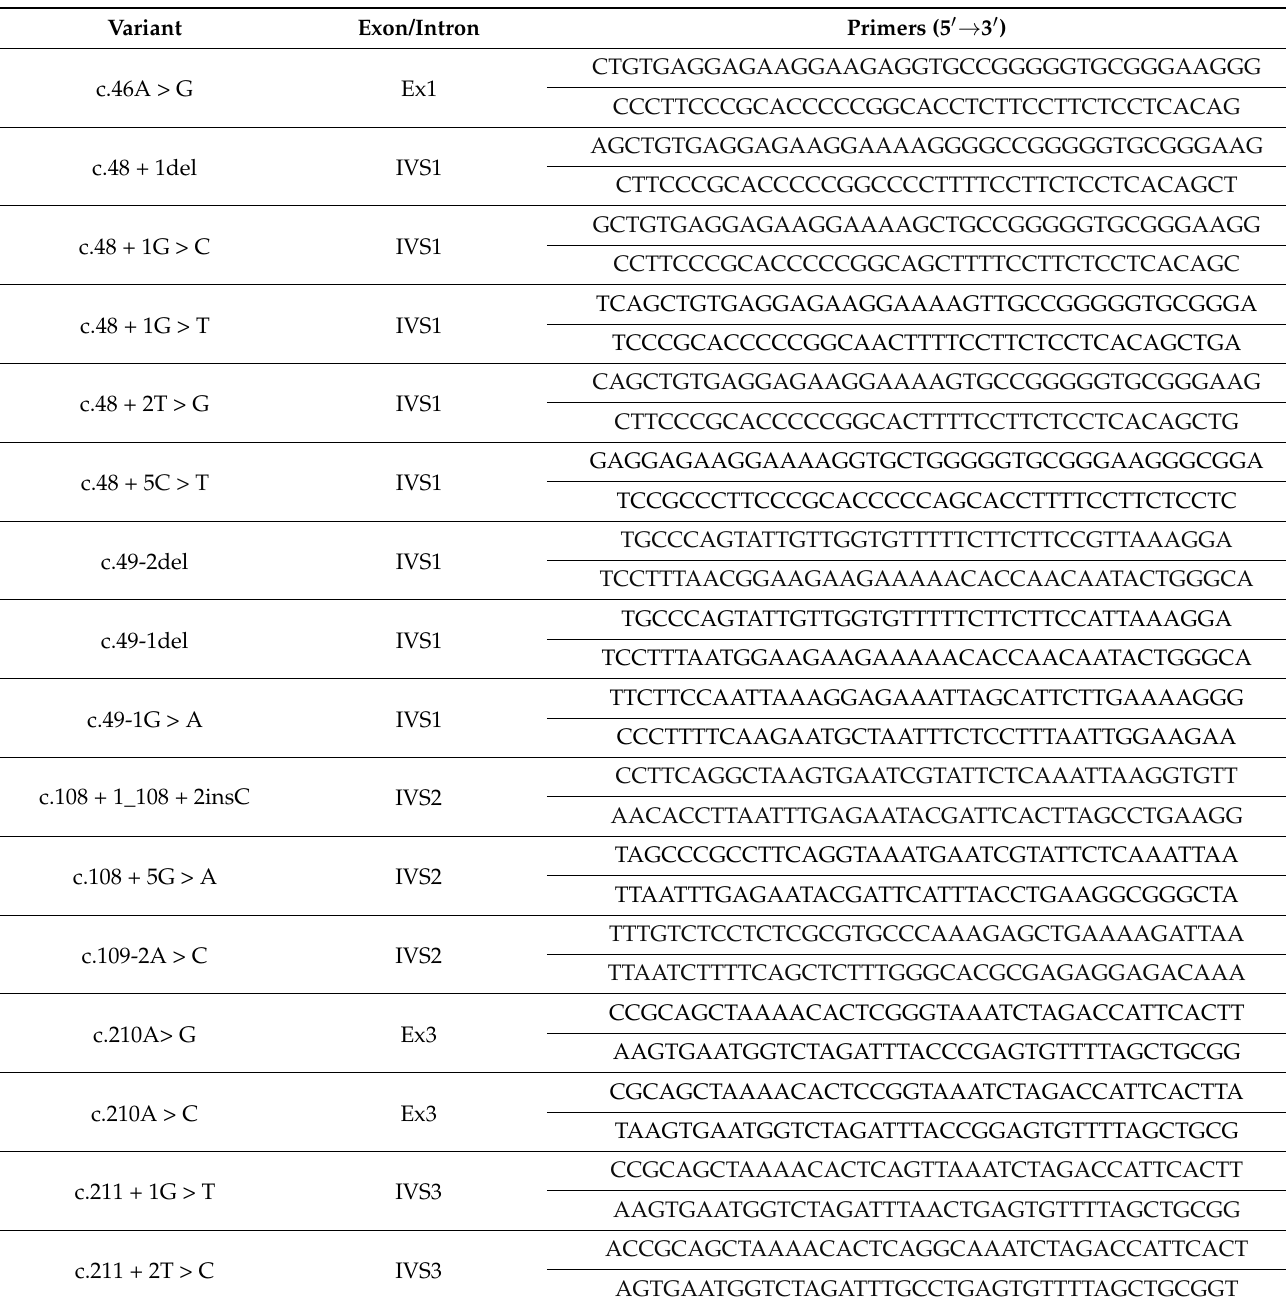
Table 1. Mutagenesis primers of PALB2